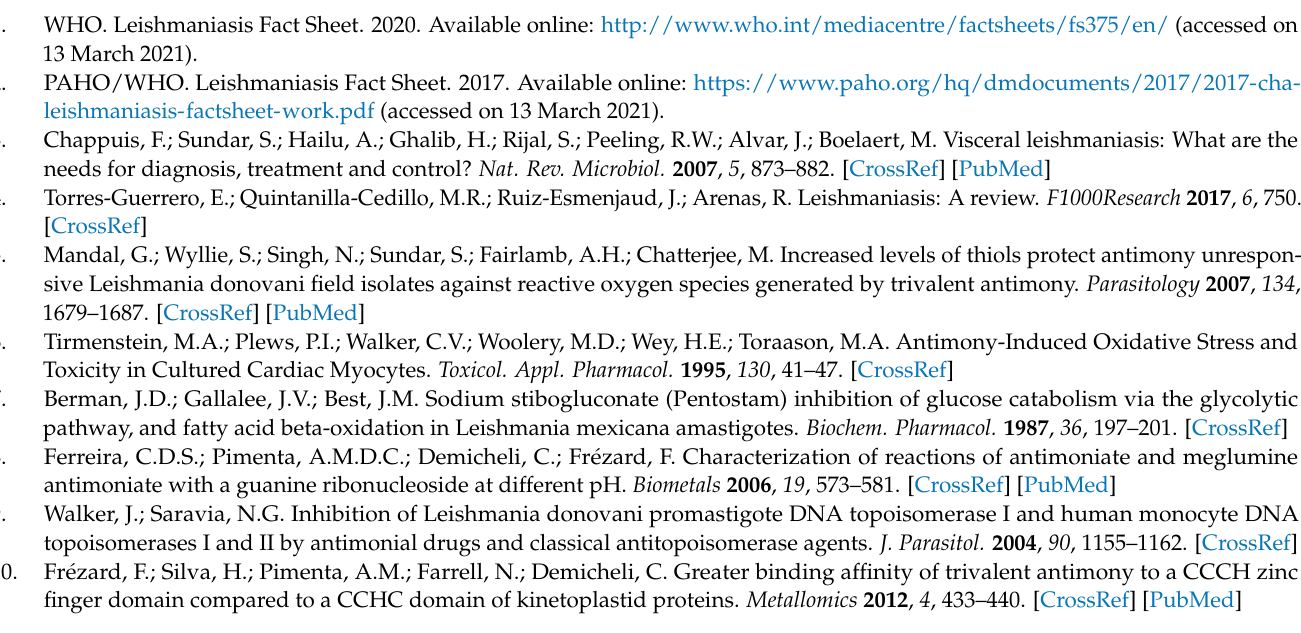
tracellular metabolomic analysis. Figure S2: Comparison of the curves of growth between the 3 L. tropica strains. Table S1: Chemical shifts per compound detected in 1 H-NMR spectra of Leishmania ’s intracellular extracts. Table S2: Chemical shifts per compound detected in a 1 H-NMR spectrum of Leishmania ’s extracellular extracts. Table S3: Raw data from Venn diagram comparing the dif- ferent and common compounds detected at the intracellular and extracellular level in Leishmania parasites by 1 H-NMR. Table S4: Total compounds detected by 1 H-NMR in L. tropica distributed by the metabolites main class. Table S5: Total compounds distributed by KEGG metabolic pathway. Table S6: Comparison of statistical measures calculated for the supervised OPLS-DA models for the differentiation of Sb III -sensitive and -resistant parasites at the intracellular and extracellular levels. Figure S3: Regression coefficients and VIP scores based on the metabolomic profiling dataset for the OPLS-DA models comparing Sb III -resistant parasites versus Sb III -sensitive parasites. Figure S4: Sb III -resistant parasites showed better tolerance to oxidative stress induced by hydrogen